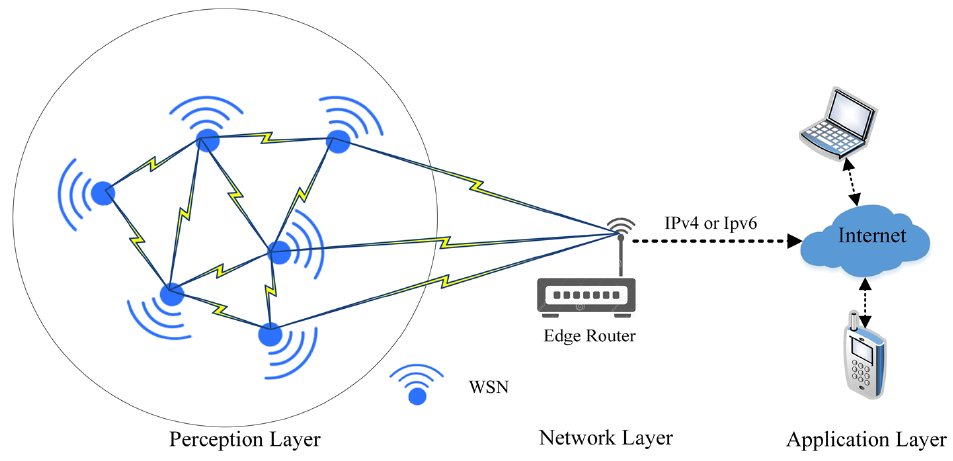
Figure 2. The communication among the WSN layers.